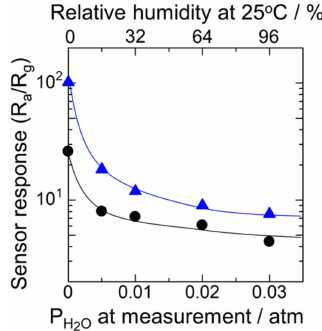
Figure 7. Relationships between the sensor response to 200 ppm H 2 at 350 ◦ C as a function of P H2O in measurement after ( ) dry and ( (cid:78) ) humid aging (P H2O is 0.03